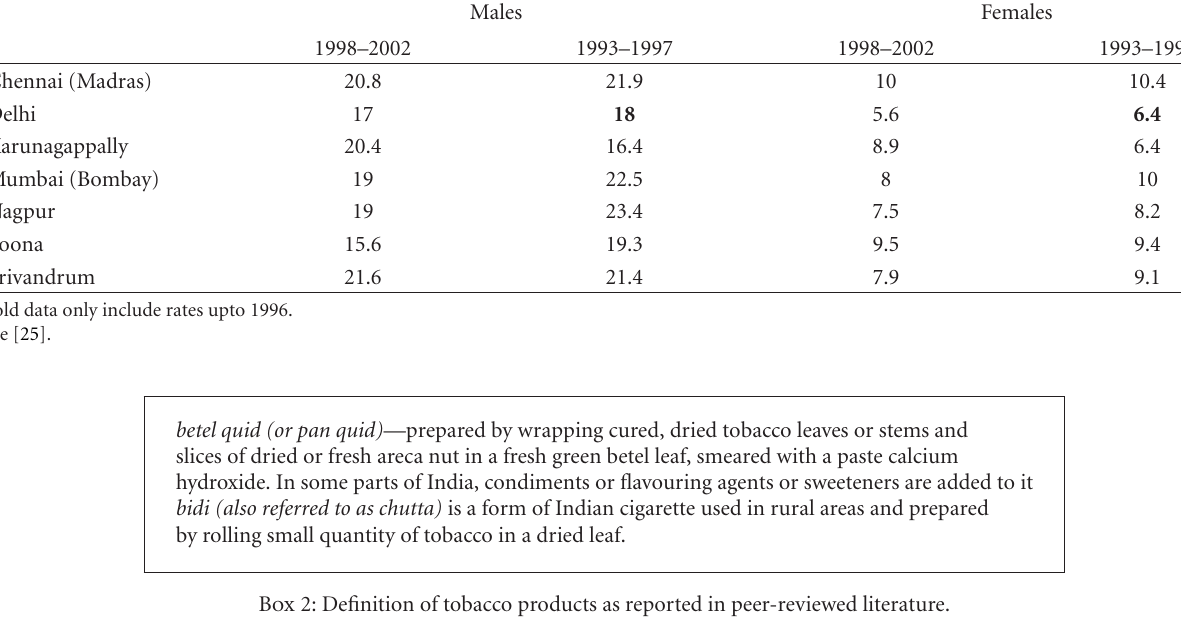
Table 7: Comparison of age standardized incidence rates per 100,000 by time, location and gender. Males